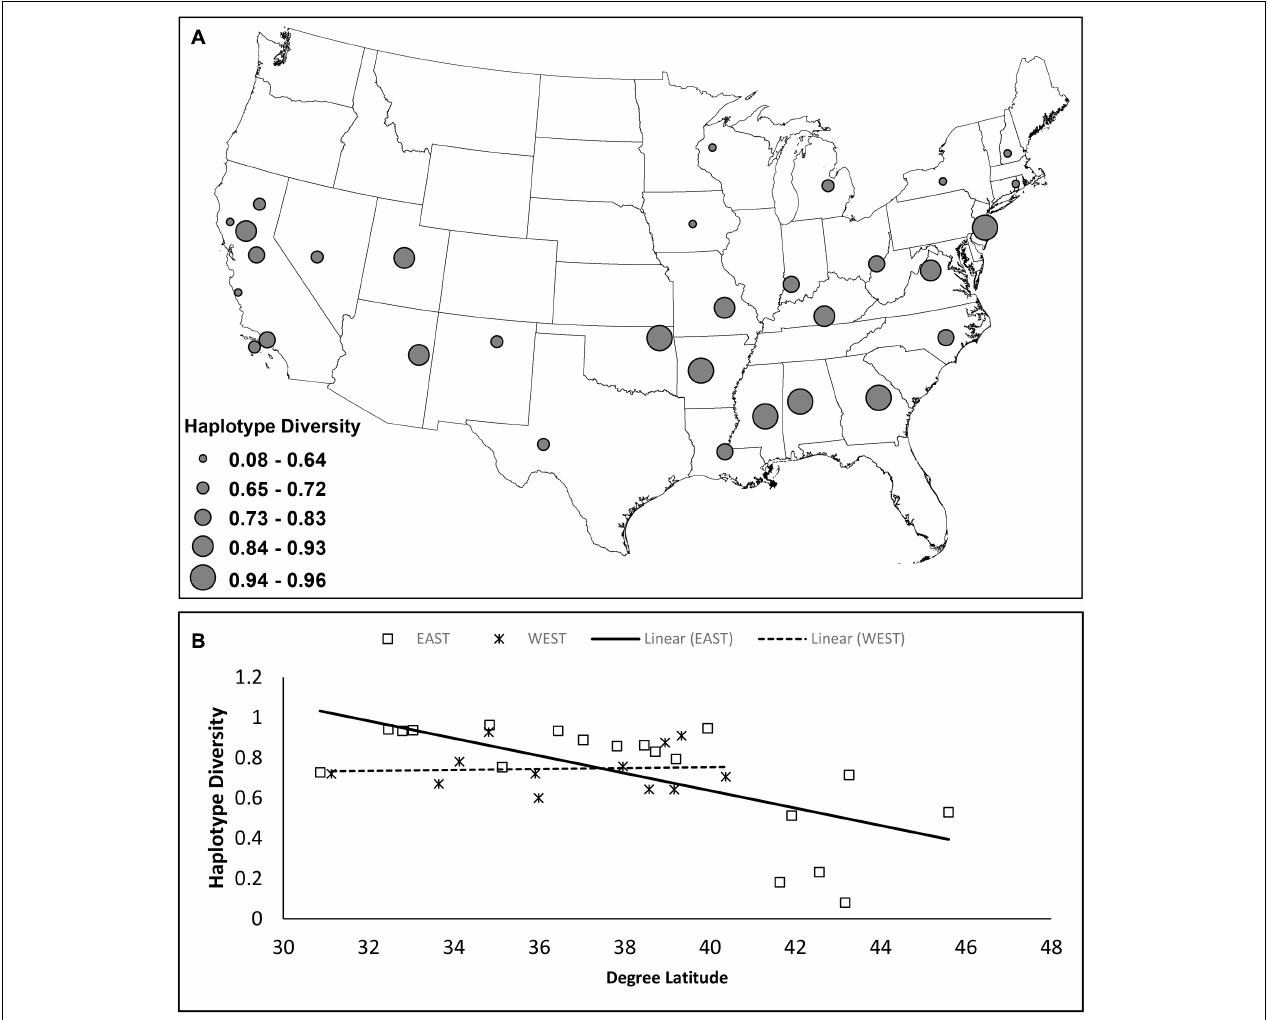
FIGURE 3 | Estimates of haplotype diversity for 31 gray fox sample groups ( n > 10) based on 400 bp of mtDNA control region. (A) Circles are located at the geographic mean center of each sample group and size reflects the quantile of the haplotype diversity value. (B) Linear regression of haplotype diversity by latitude for East and West sample